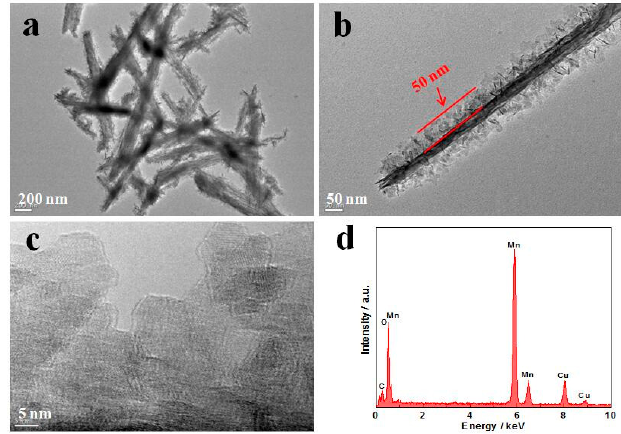
Figure 3. ( a – c ) TEM images with different magnification; and ( d ) EDX (Energy-dispersive X-ray) spectrum of MnO 2 @MnO 2 .